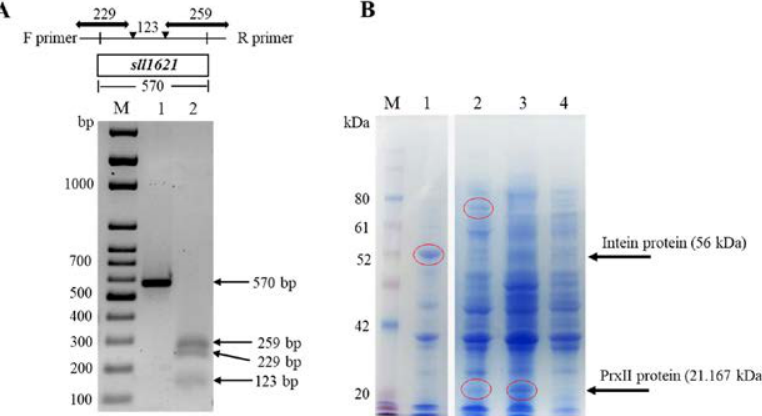
Fig. 3. Isolation and expression of sll1621 gene in E. coli BL21 (DE3) cells. (A) PCR amplification of sll1621 gene that isolated from the genomic Synechocystis PCC 6803 (lane 1),while, lane 2 represented the restriction map of the sll1621 gene using Eco RI. (B) SDS-PAGE analysis of the recombinant PrxII protein after addition of IPTG. Lane 1, E. coli cells transformed with pTYB21 /empty vector that cultured at 15°C for 16 hours; lane 2, E. coli cells transformed with pTYB21/sll1621vector that cultured at 15°C for 16 hours; lane 3, E. coli cells transformed with pTYB21/sll1621 vector that cultured at 36°C for 3 hours; lane 4, E. coli cells transformed with pTYB21 /empty vector that cultured at 36°C for 3 hours; lane M, PiNK plus prestained protein ladder